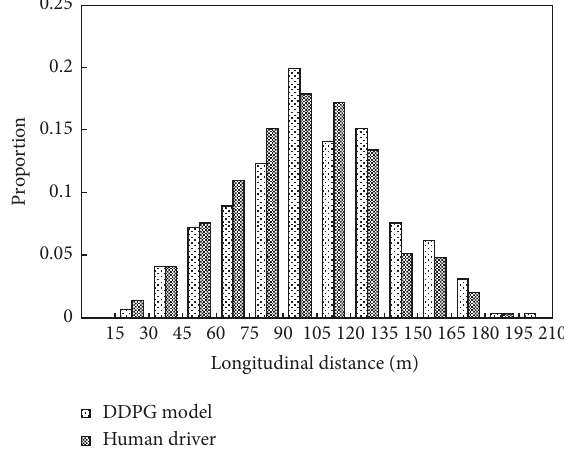
Figure 10: Longitudinal distance distribution. Table 2: Detailed results of the testing